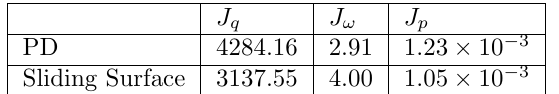
Table 2: Values of performance functionals for